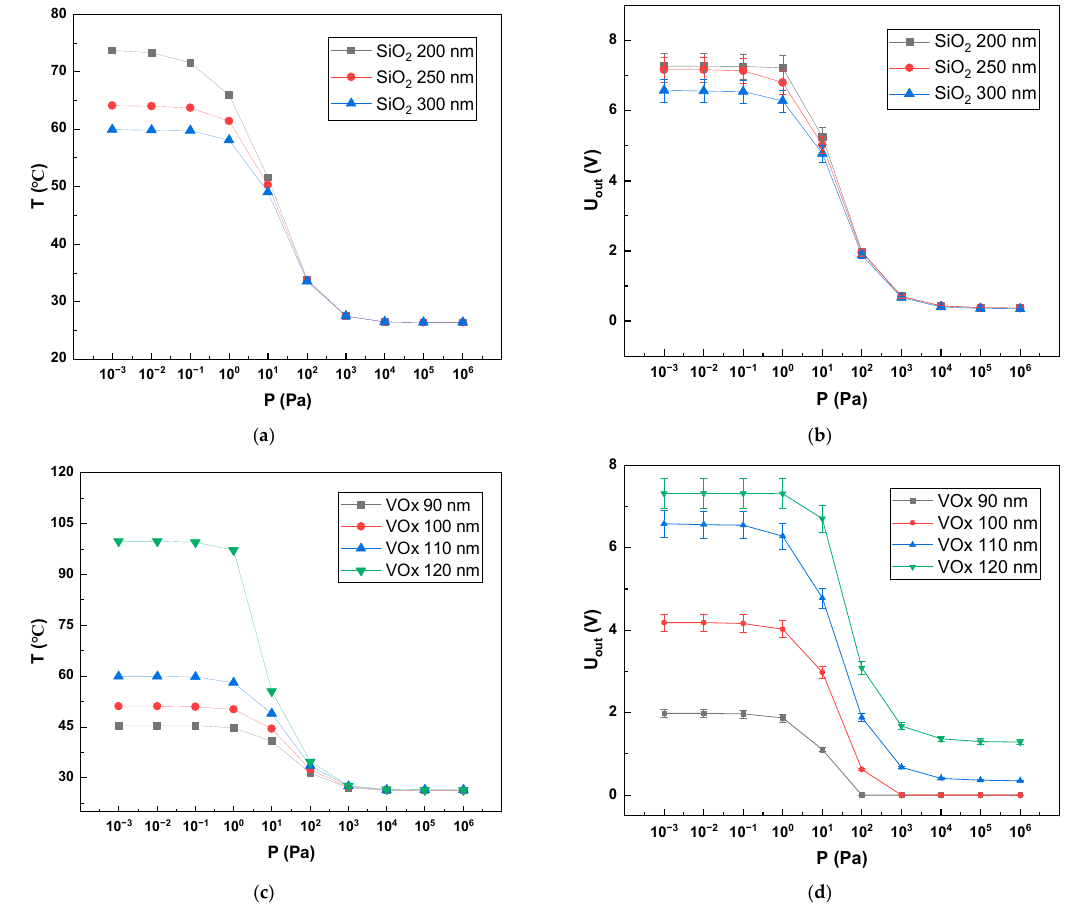
Figure 7. VOx temperature and output voltage for different film thicknesses. ( a ) Trend of VOx film temperature with pressure for Pirani gauge with different SiO 2 thicknesses; ( b ) Trend of output voltage with temperature for devices with different SiO 2 thicknesses; ( c ) Trend of thermal layer temperature with pressure for devices with different VOx thicknesses; ( d ) Trend of output voltage with pressure for devices with different VOx